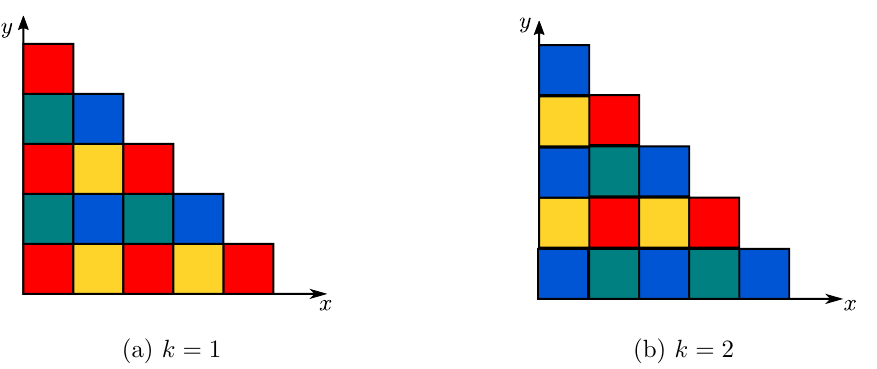
Figure 12. Slice of the three-dimensional crystal at k = 1 and k = 2 . The coordinates of the boxes are assigned ( i, j, k ) ( i, j, k ∈ Z ) . (a) Patterns of coloring of boxes when k = 1 . (b) Patterns of > 0 coloring of boxes when k = 2